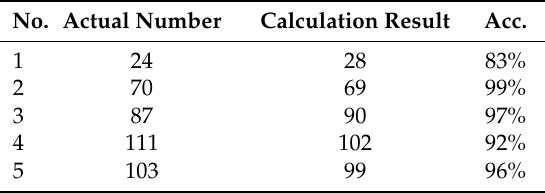
Table 4. Results for 5 panicle samples from a RIL population *.